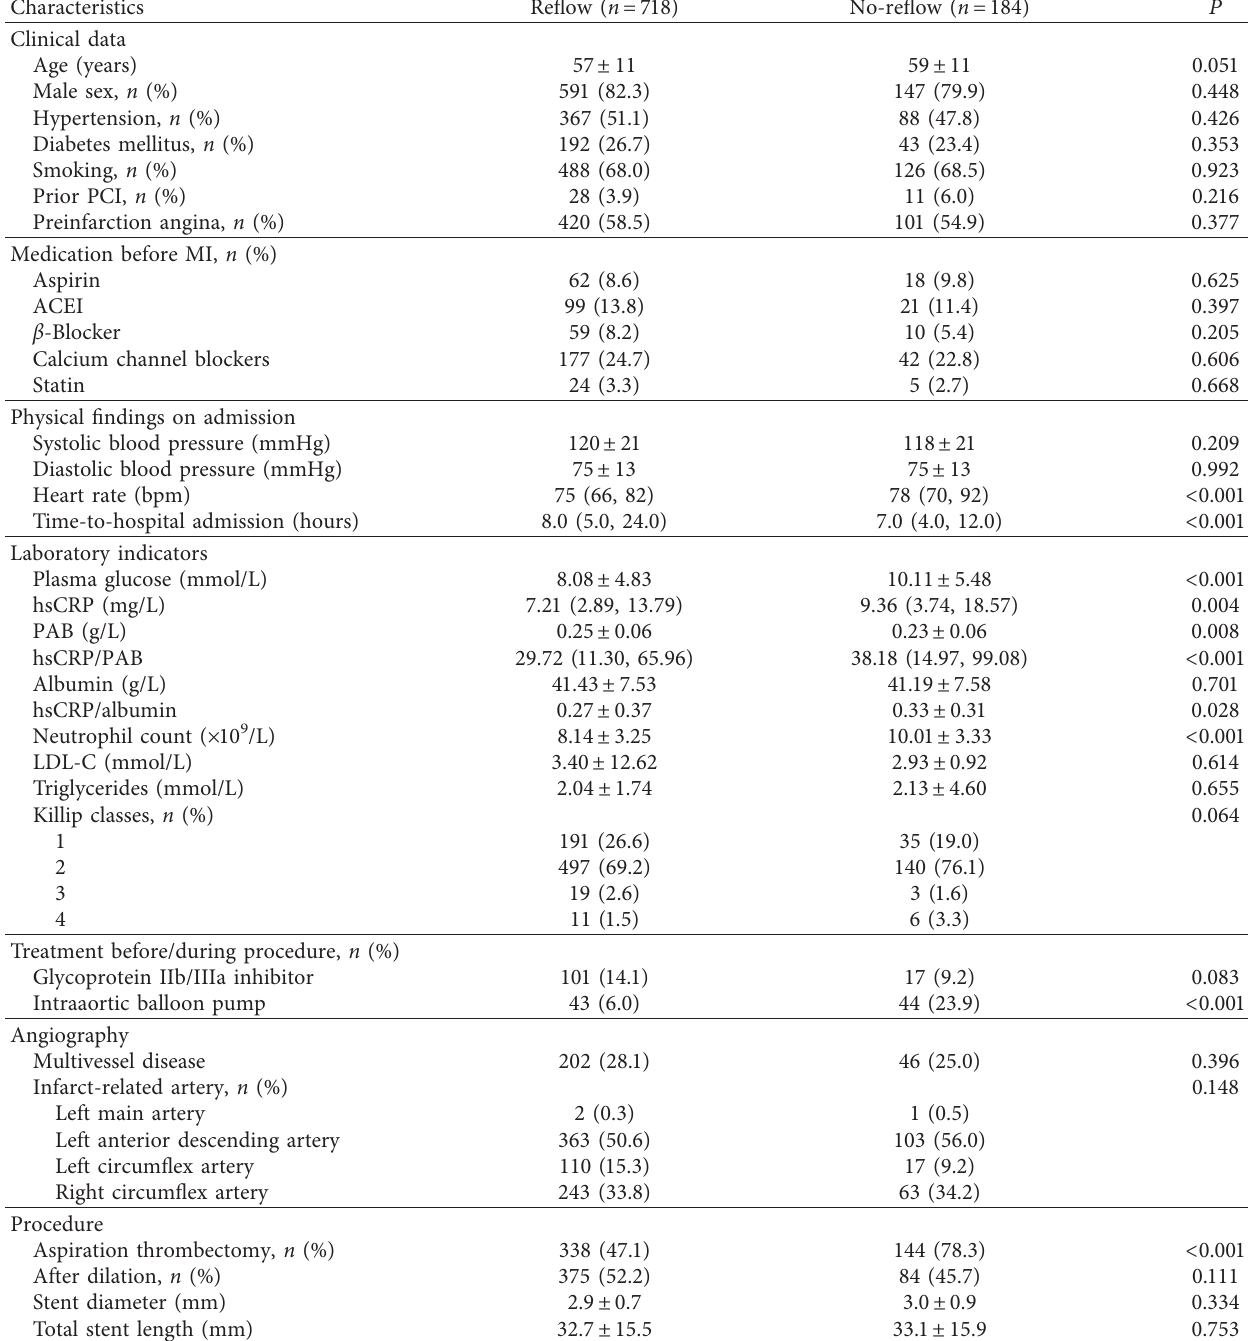
Table 1: Clinical, angiographic, and procedural data for